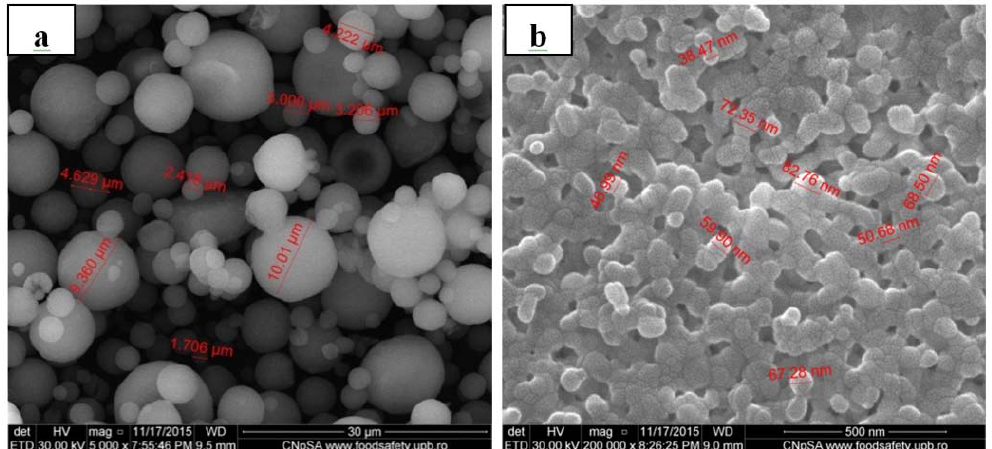
Figure 2. ( a ) Scanning Electron Microscopy (SEM) image of HAp nanopowder; ( b ) SEM image of HAp sintered at 800 °C/30 min.